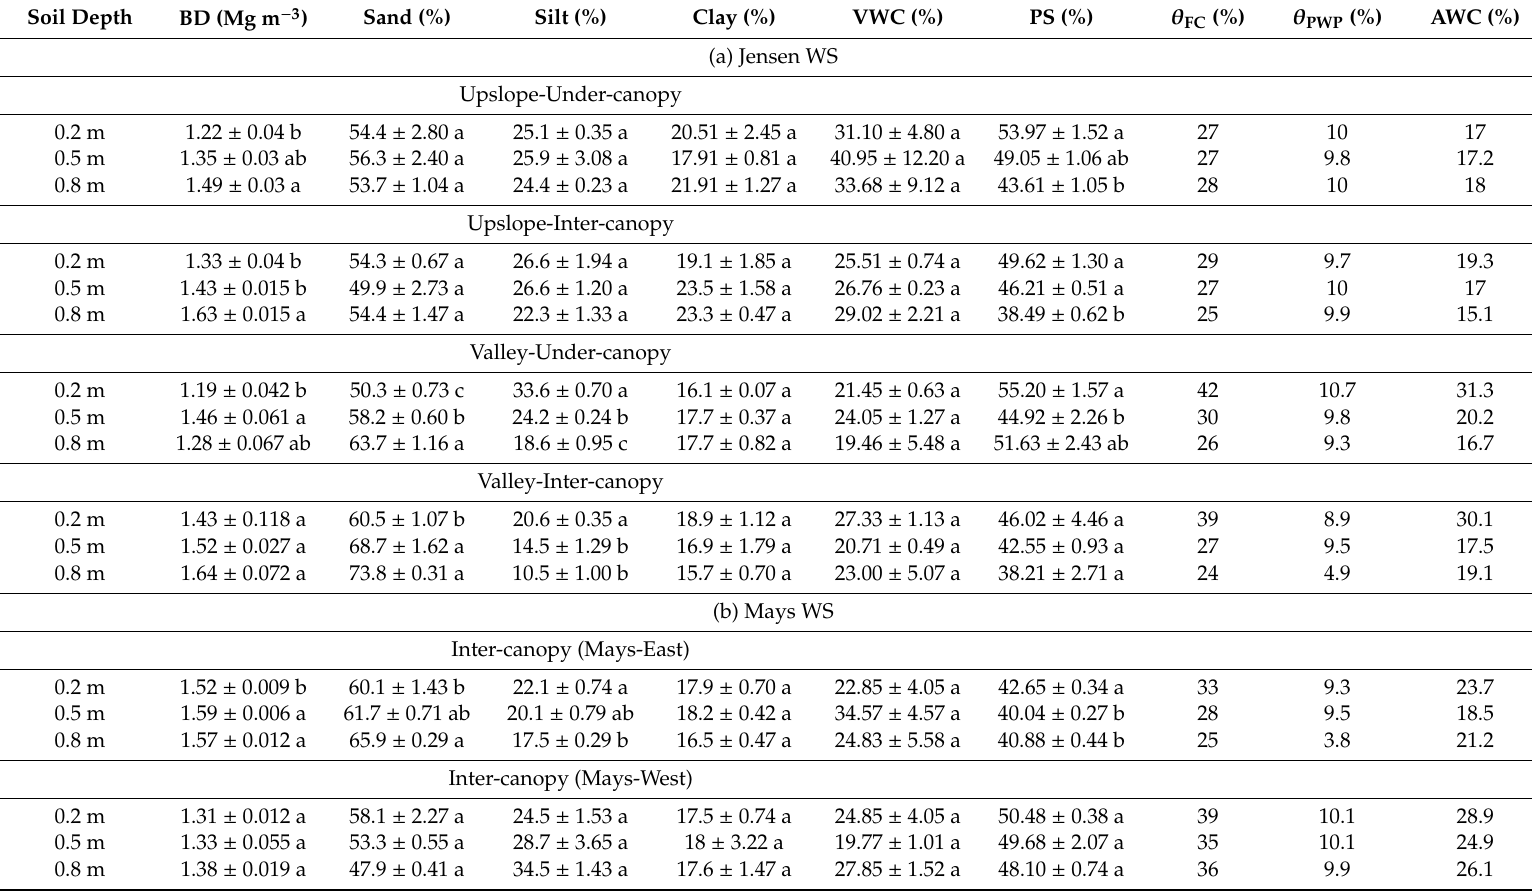
Table A1. Soil physical properties for the paired watersheds within the study area, (a) Jensen WS and (b) Mays WS, showing the mean and standard error ( n = 3) of soil bulk density, soil particle distribution of sand, silt, and clay, volumetric water content and soil porosity at each soil depth. Additionally, mean θ values at permanent wilting point ( θ PWP ), field capacity ( θ FC ), and available water content (AWC) are identified for each soil depth. The Jensen WS location illustrates data collected at under-canopy and inter-canopy area in upslope and valley settings. Means with the same letter superscripts (a, b) along columns indicate no significant di ff erences for soil depths ( p <